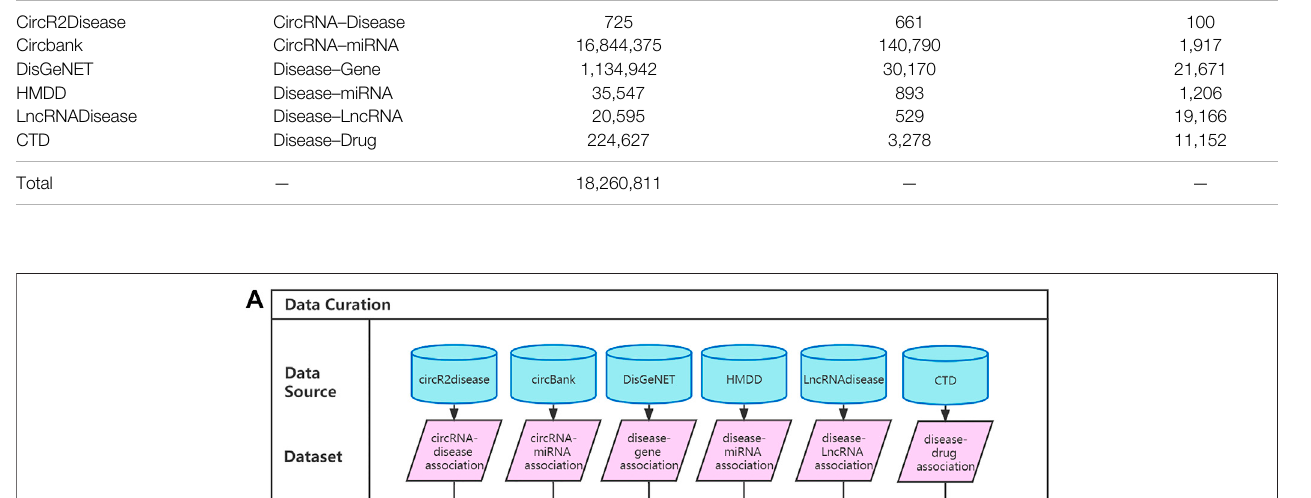
Frontiers in Genetics |